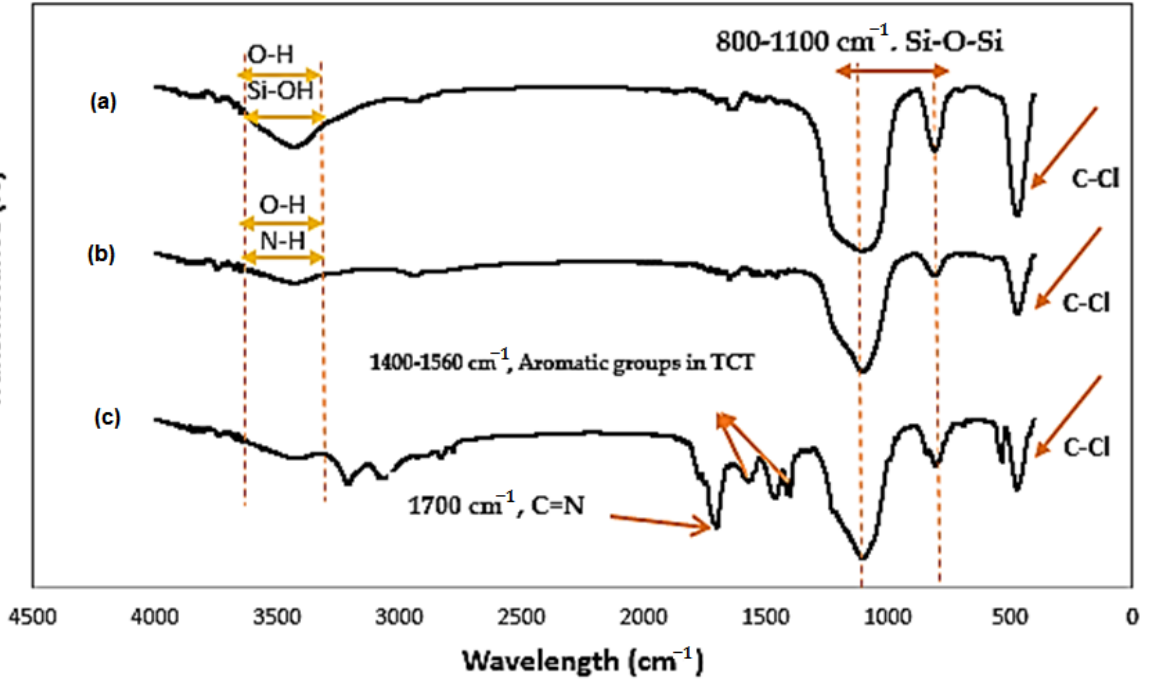
Figure 1. FT-IR analysis of ( a ) fumed-Pr-Cl, ( b ) fumed-Pr-Pi, and ( c ) fumed-Pr-Pi-TCT.